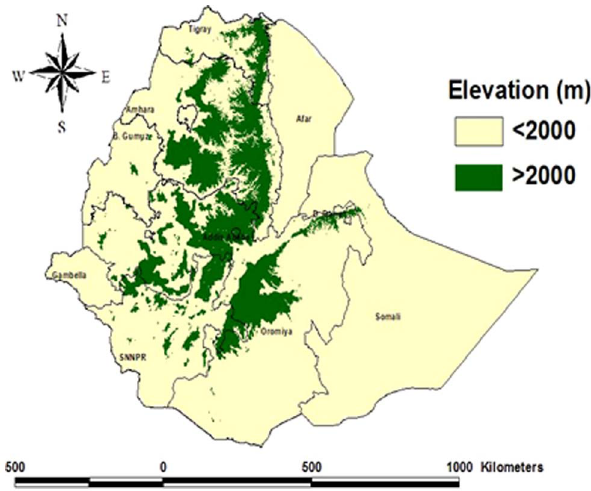
Figure 1. Administrative regions and areas below and above 2000 meters elevation in